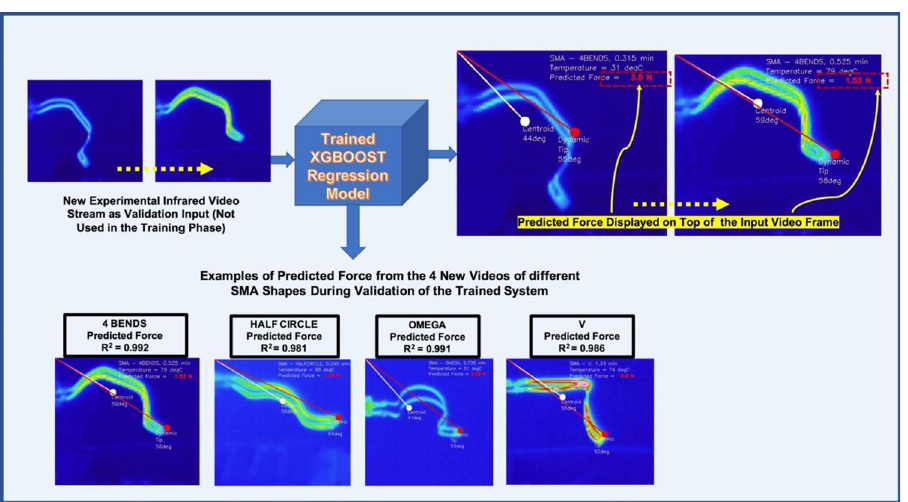
Fig 7. Results of prediction from the trained XGBoost model during the blind validation stage, where R 2 score of predictions varied on a range of 0.981–0.992 and predicted force was displayed on top of the video frames